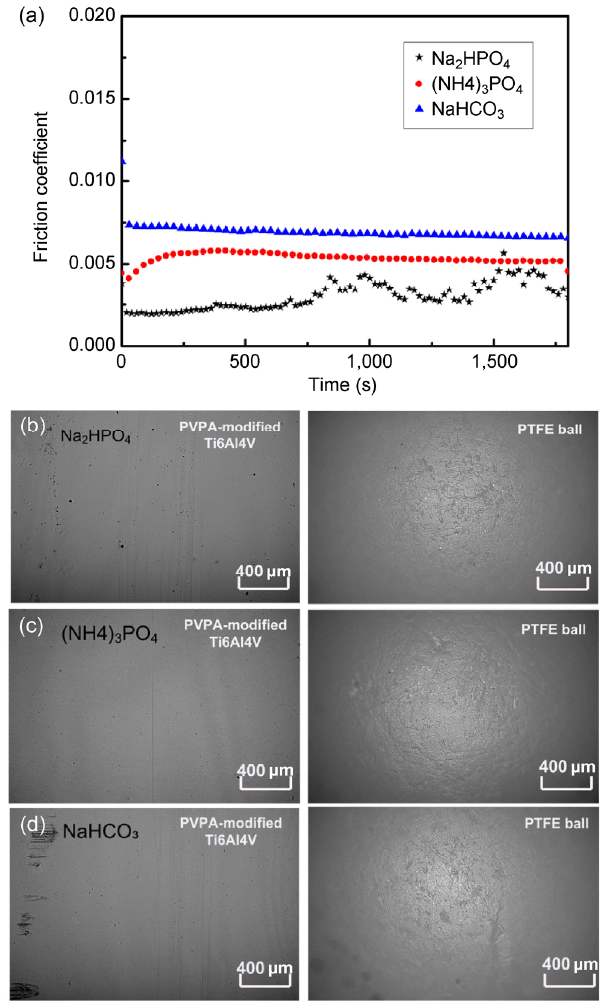
Fig. 4 Tribological properties of PVPA-modified Ti6Al4V in different lubricants: (a) average friction coefficients versus time, (b) surface topography on two tribo-pairs after sliding for 0.5 h in Na 2 HPO 4 , (c) surface topography on two tribo-pairs after sliding for 0.5 h in (NH 4 ) 3 PO 4 , and (d) surface topography on two tribo- pairs after sliding for 0.5 h in NaHCO ₃